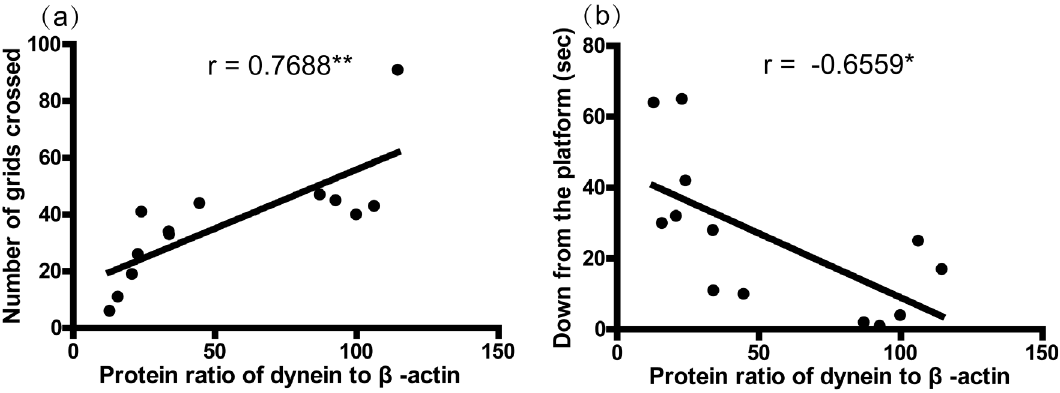
Figure 4. Correlations between the motor behaviors and dynein protein levels in the striatum (n = 13; nTg, n = 5; A53T, n = 8). The correlation analysis between number of grids crossed ( a ), time to get down from the platform ( b ), and the protein levels of dynein in the striatum was performed by the Pearson’s correlation test. Asterisks (*) show the significance of the correlation (two tailed). * p <0.05, ** p <0.01.